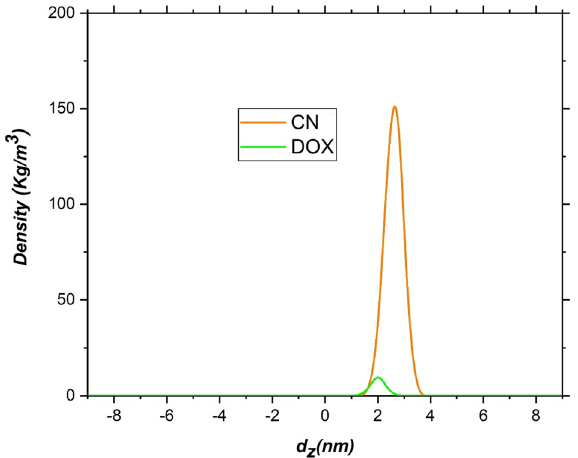
Figure 10. The density profile of DOX and CN in the difuusion simulation box.